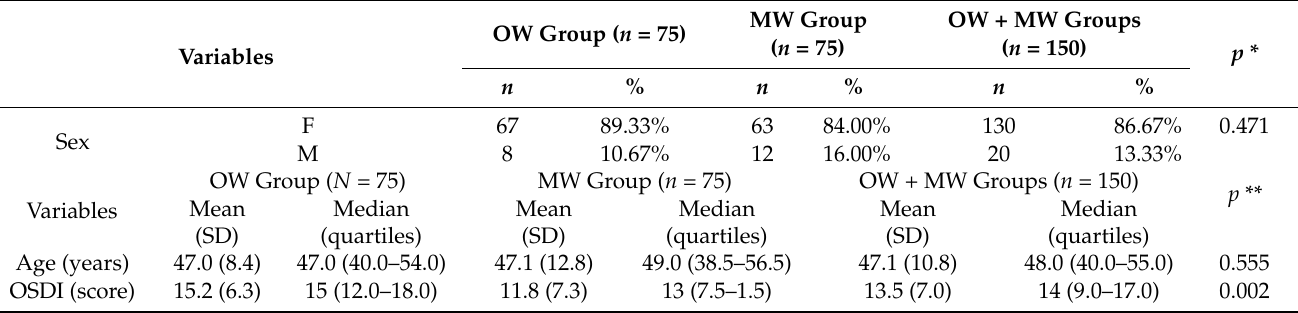
Table 1. Comparison of demographic data at